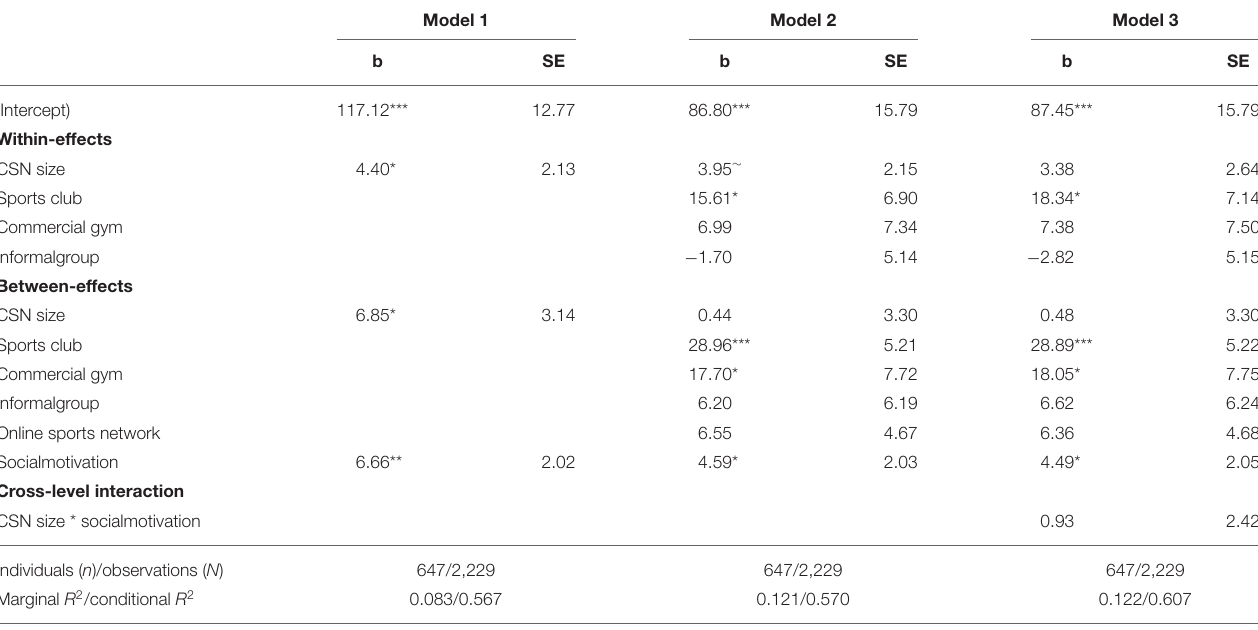
TABLE 1 | Between-within effects of Core Sports Network (CSN) size on running frequency, panel